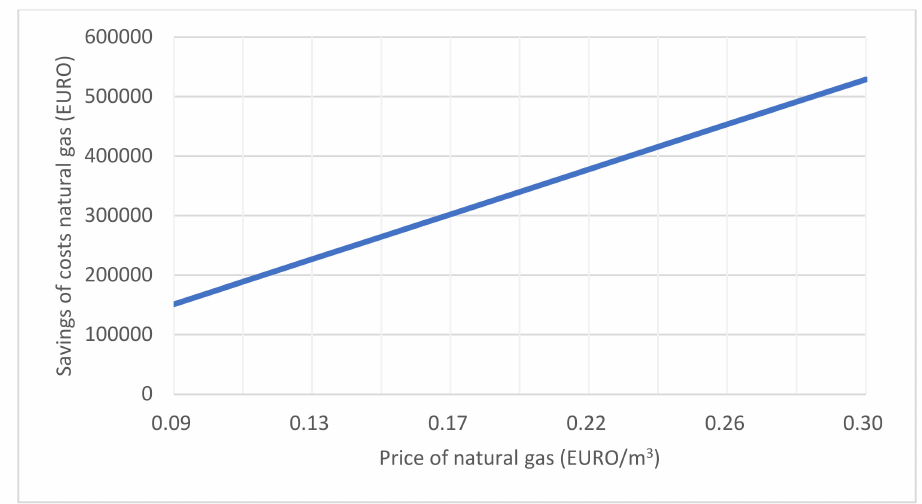
Figure 7. Savings of natural gas costs when co-incineration of waste gases operating 8500 h /